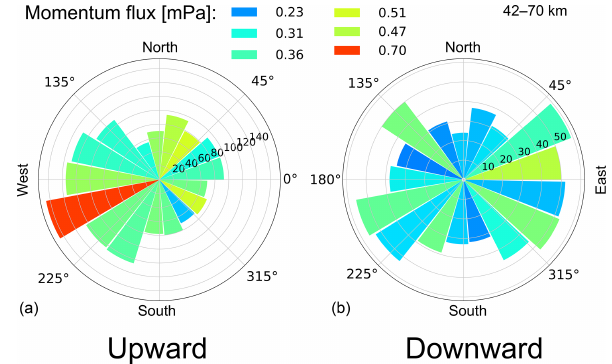
Figure 19. Polar histogram of upward-propagating (a) and downward-propagating (b) waves limited to the altitude range from 42 to 70km. The length of the bars represents the number of waves per given horizontal direction. The average momentum flux per 20 ◦ directional bin (in mPa) is